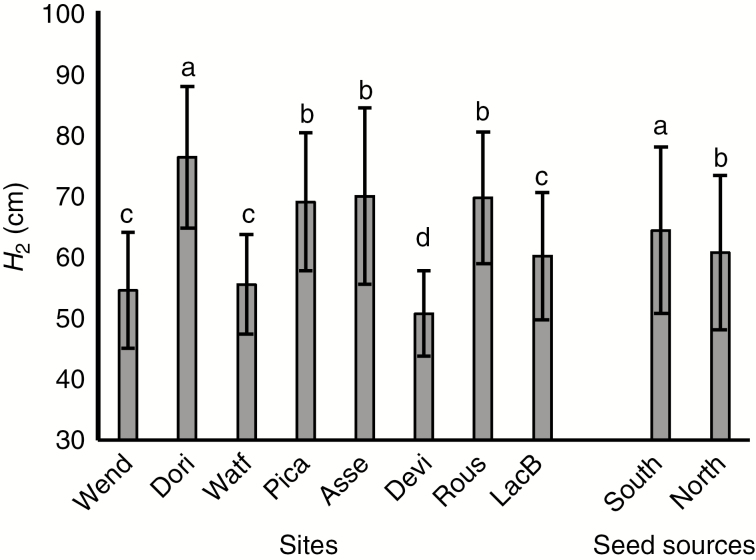
Total height (mean ± s.d.) at the end of the second growing season (H2) of white spruce seedlings from two seed sources grown at eight forest plantation sites. Means having the same letters are not significantly different at α = 0.05. Wend, Wendover; Dori, Dorion; Watf, Watford; Pica, Picard; Asse, Asselin; Devi, Deville; Rous, Rousseau; LacB, Lac Bergeron; South, southern seed source (SO1-1); north, northern seed source (SO1-5).